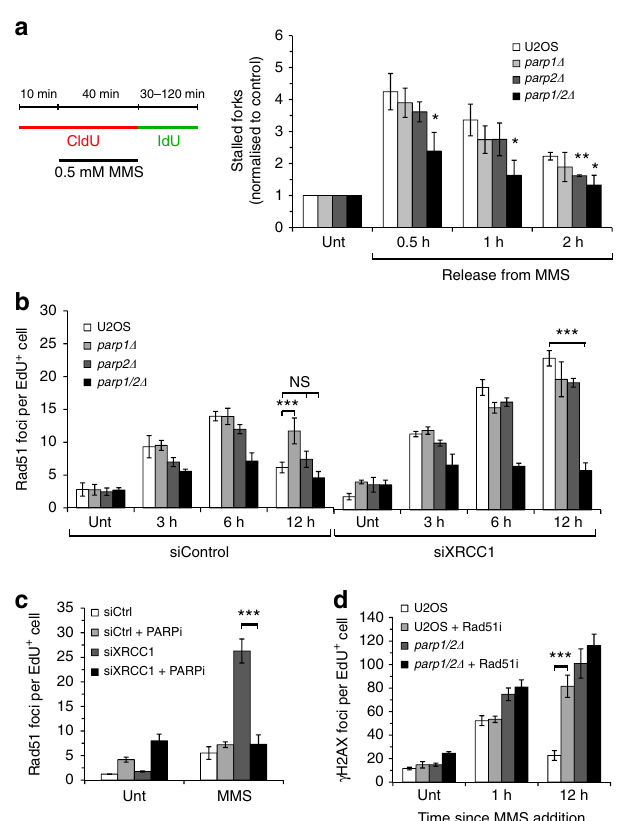
Fig. 4 Assembly of Rad51 at damaged replication forks is compromised in the absence of PARP1 and PARP2. a DNA fi bre analysis was performed in the indicated cells after MMS exposure and recovery for the times shown. The number of stalled forks (red-only tracts) was determined as a ratio of all red-labelled replication structures. These values were subsequently normalised to the equivalent ratio in the corresponding non-treated sample. Error bars represent the SEM from at least three independent experiments. Statistical signi fi cance from the normalised ratio of stalled forks in parental U2OS cells was determined using a two-tailed Student ’ s t-test (NS, not signi fi cant; * p < 0.05; ** p < 0.01; *** p < 0.001). b The indicated cell lines transfected with control or XRCC1 siRNA were treated with 1 μ M EdU (Unt), or with 1 μ M EdU and 0.5 mM MMS for 1 h before recovery in fresh media, and Rad51 foci quanti fi ed in EdU-positive cells. Times indicated show hours since addition of EdU and MMS. Error bars represent the SEM from three independent experiments. Statistical signi fi cance was determined as in a . c U2OS cells transfected with control or XRCC1 siRNA were treated as in b and Rad51 nuclear foci analysed in EdU-positive cells. Cells were fi xed 12 h after addition of EdU and MMS. Error bars represent the SEM from three independent experiments. Statistical signi fi cance was determined as in a . d U2OS or parp1/2 Δ cells, in the presence or absence of 50 μ M B02 (Rad51i), were treated as in (3 C) and γ -H2AX foci quanti fi ed in EdU-positive cells. Times indicated show hours since addition of EdU and MMS. Error bars represent the SEM from three independent